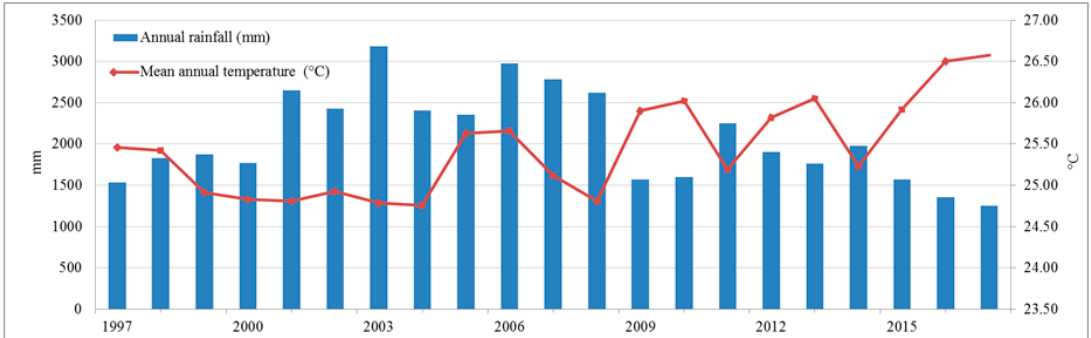
Figure 3. Gambella National Regional State average annual rainfall (mm) and mean annual temperature (°C) (1997–2017) from ERA-interim reanalysis data-set.